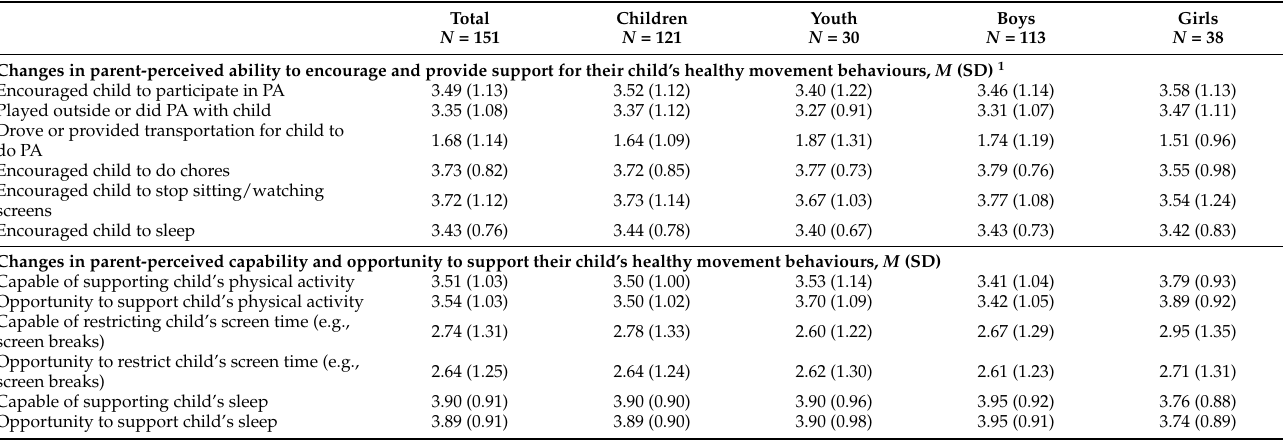
Table 5. Parent-reported changes in their ability to support their child’s healthy movement behaviours during the COVID-19 pandemic (May 2020; N =